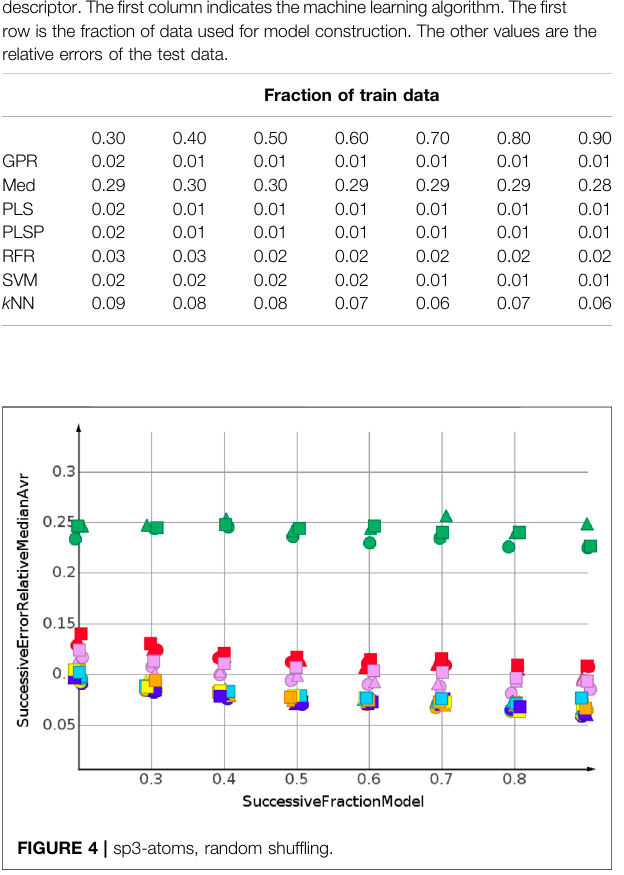
FIGURE 6 | Molecular weight, high to low sorted response